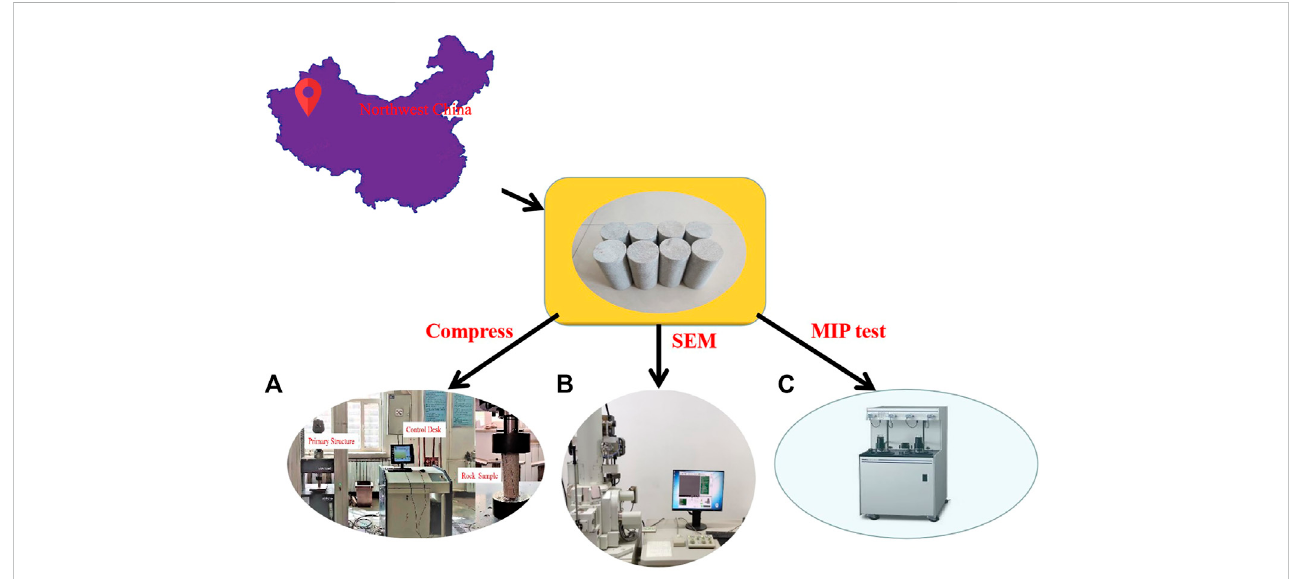
FIGURE 2 Main experimental instruments and processes.